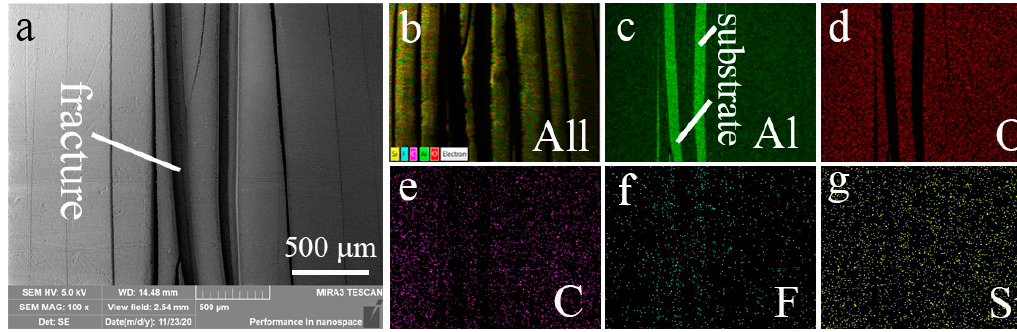
Figure 14. ( a ) SEM image and ( b – g ) EDS elemental mapping of the bending fracture.